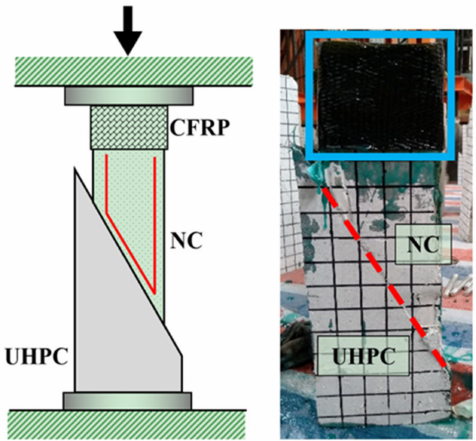
Figure 2. “Improved” slant shear